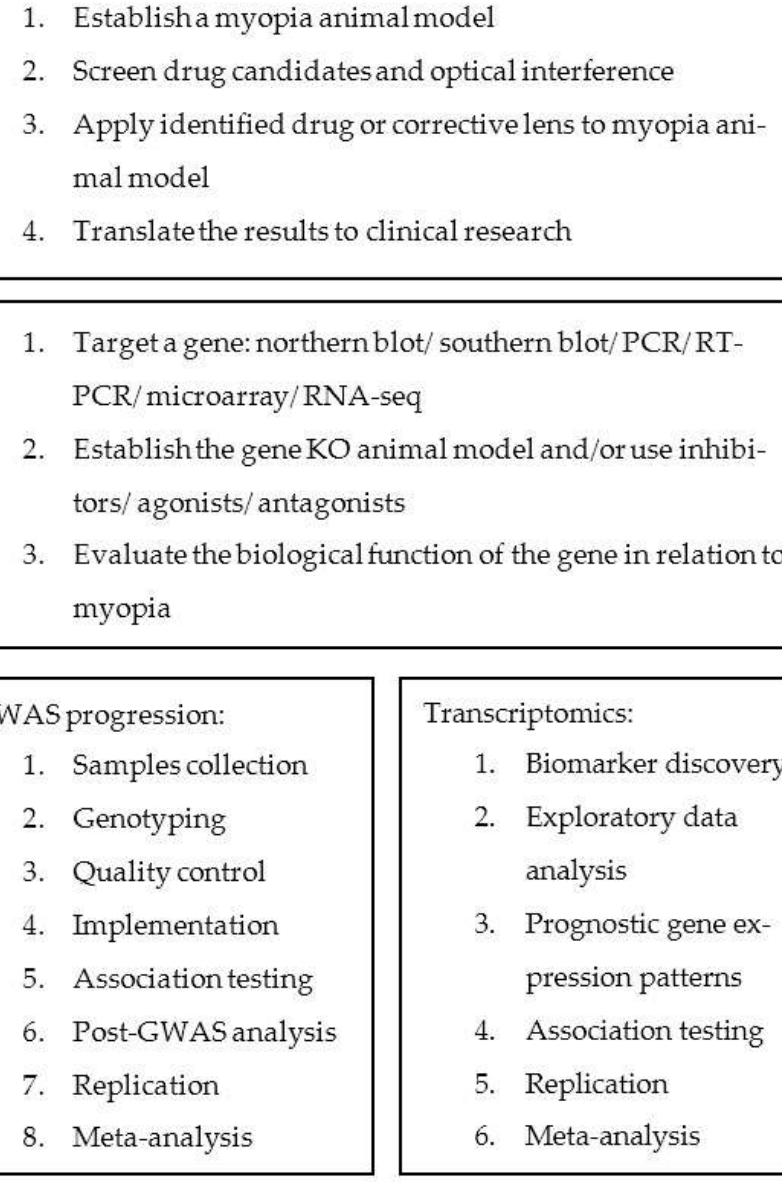
Figure 1. The general pipeline of precision medicine of a novel myopia therapy from gene discovery to clinical translation.